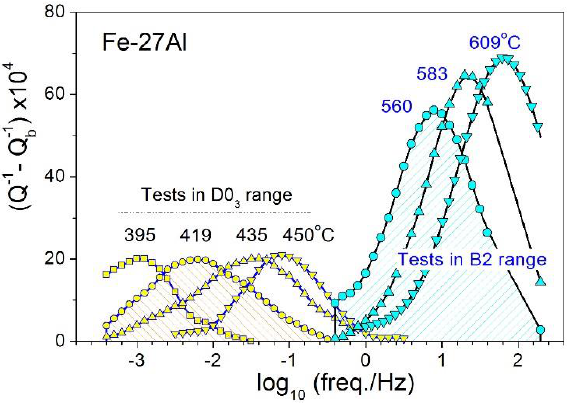
Figure 25. Frequency-dependent internal friction after background subtraction for Fe–27Al alloy measured at fixed temperatures during step-by-step increase in temperature in order to correspond to the ranges of D0 3 and B2 phases [86].